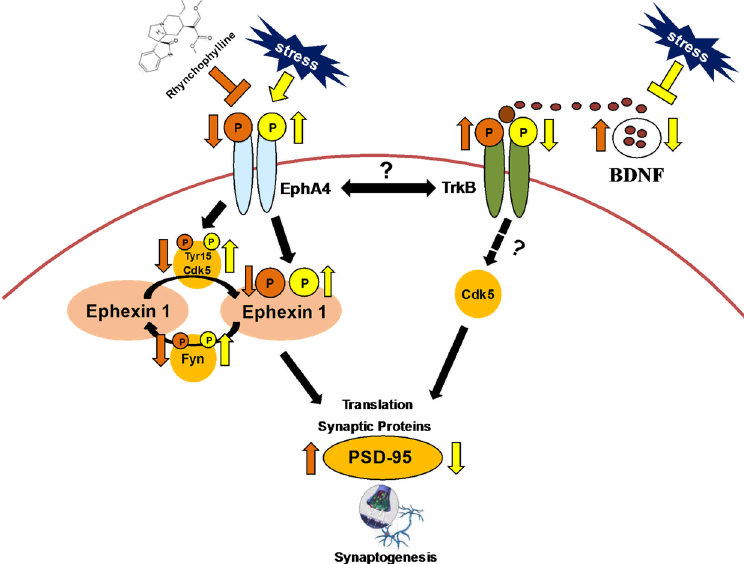
Figure 7. Working model of the EphA4–ephexin1 signaling pathway and BDNF-TrkB signaling pathway in the model of depression. Social defeat stress promotes the activation of EphA4–ephexin1 signaling, which mediates synaptic loss. The activation of EphA4 by stress enhances the activity of Cdk5 via the phosphorylation of Cdk5 at Tyr15 and ephexin1. The activation of Cdk5 at Tyr15 and Fyn promotes ephexin1 phosphorylation, thereby leading to decreased synaptogenesis and dendrite atrophy. Social defeat stress inhibits BDNF-TrkB signaling, which could mediate synaptic loss. Rhynchophylline attenuates the activation of EphA4–ephexin1 signaling and the inhibition of BDNF-TrkB signaling in mice with the depression-like phenotype. The inhibition of EphA4–ephexin1 signaling can improve the decreased BDNF-TrkB signaling in depression, thereby improving the synaptic protein level. The inhibition of Cdk5 or absence of the Cdk5 activator p35 completely abolishes BDNF-induced spine formation and enlargement 62 , so it is likely that Cdk5 may work downstream of BDNF- TrkB